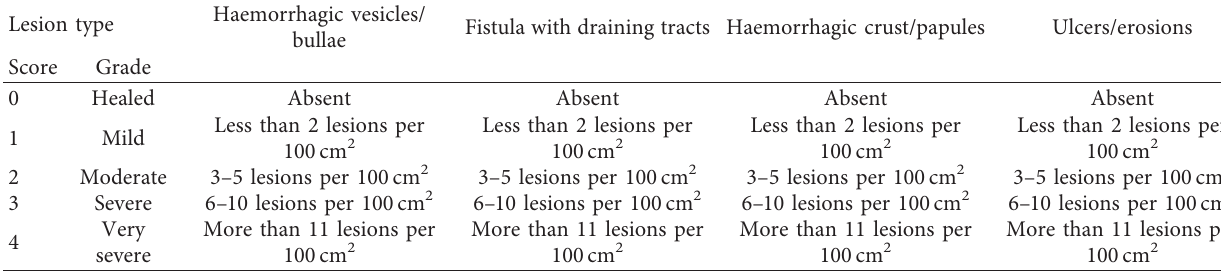
Table 1: Scoring system for